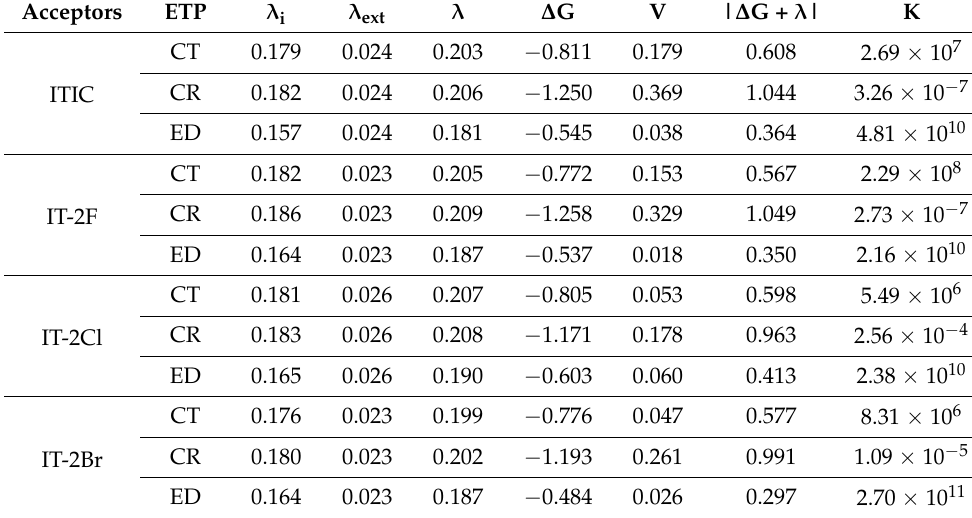
Table 7. Calculated reorganization energies λ (in eV), free energy changes ∆ G (in eV), electron coupling V (in eV) and rate constants K (in s − 1 ) of the PBDB-T:ITIC and PBDB-T:IT-2X (X = F, Cl, Br) complexes for the three electron